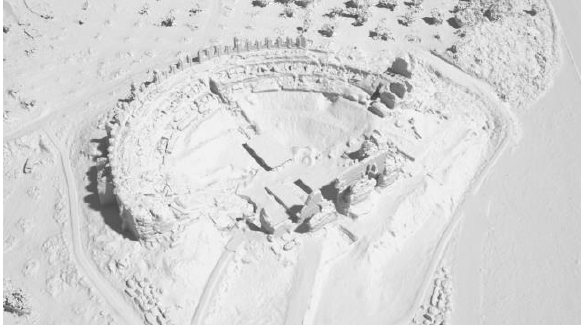
Figure 10. Untextured model of the current state of the theatre.